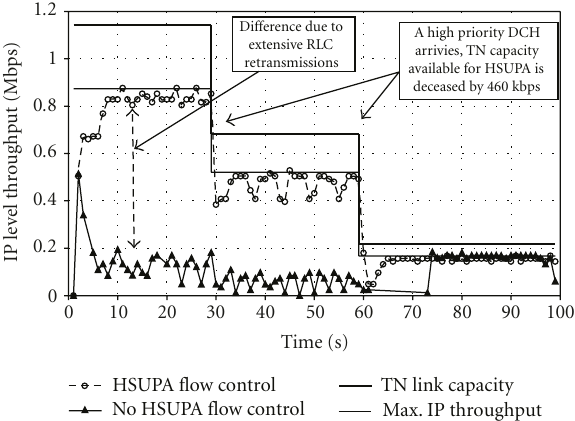
Figure 6: 1second Average IP level throughput when TN capacity is varying.